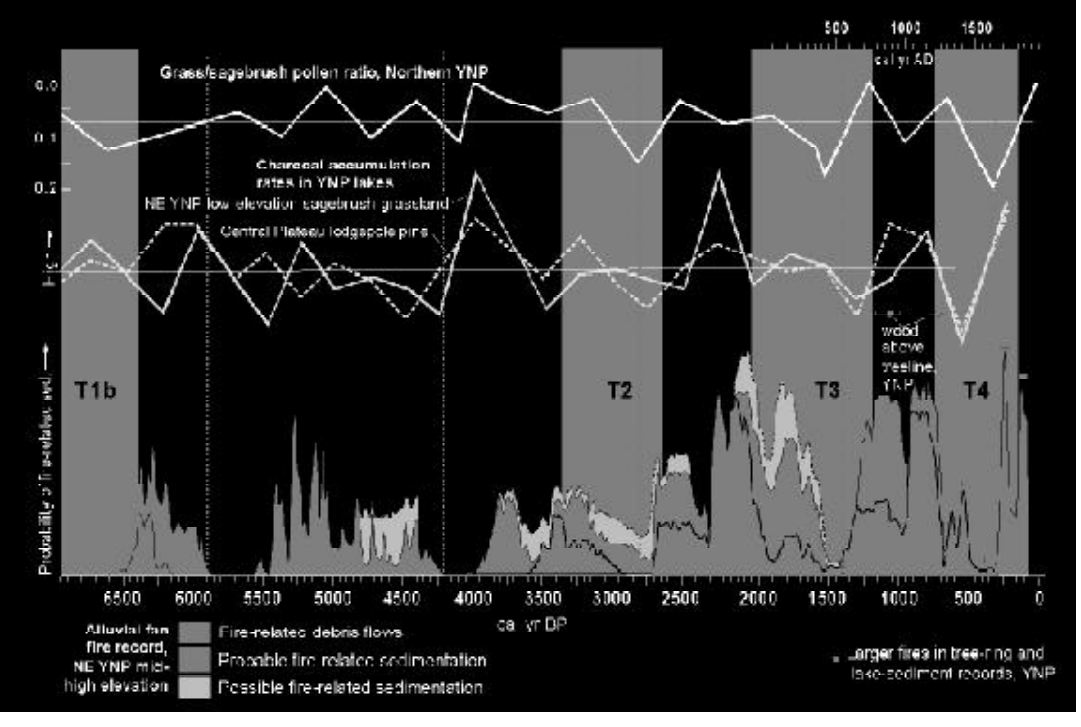
FIGURE 5. Probability of forest fires and debris-flow events following fires at Yellowstone National Park, U.S. This plot was derived from radiocarbon dating of charcoal in debris flows and soils[54,55]. (Courtesy of G. Meyer, University of New Mexico.)